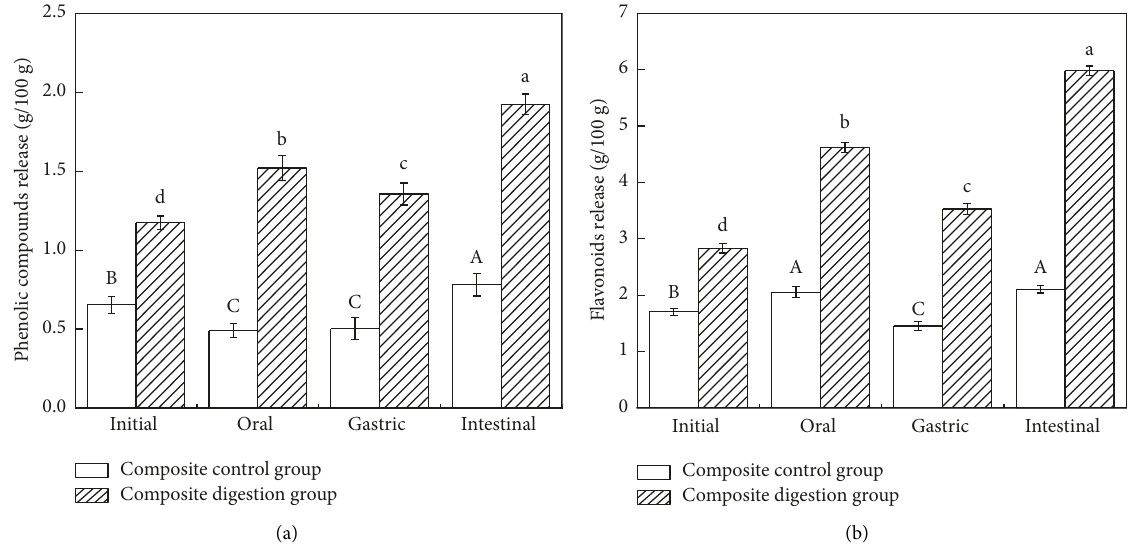
Figure 1: Changes of phenolic compounds and flavonoids from the RTBC during in vitro digestion. Data are expressed as the mean- ± standard deviation ( n � 3). (a–d) Different lowercase letters represent significant different among digestion groups. (A–D) Different uppercase letters represent the significant different among the control groups ( P < 0 .